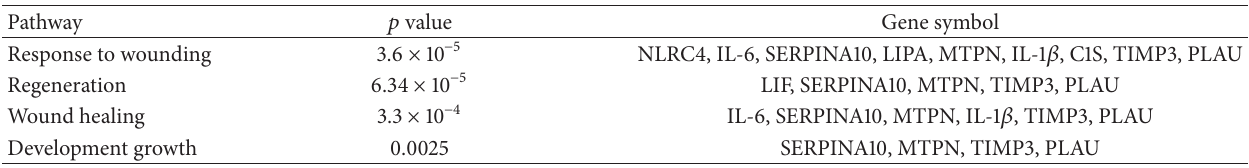
Table 2: Functional annotation clustering of genes activated ( > 1.49, 𝑝 > 0.05 ) by ZNF395 under hypoxia in U87-MG cells that were identified by microarray; annotation clusters with an enrichment score of 2.5 are shown. The adjusted 𝑝 value indicates the significance of enrichment. Pathway 𝑝 value Gene symbol Response to